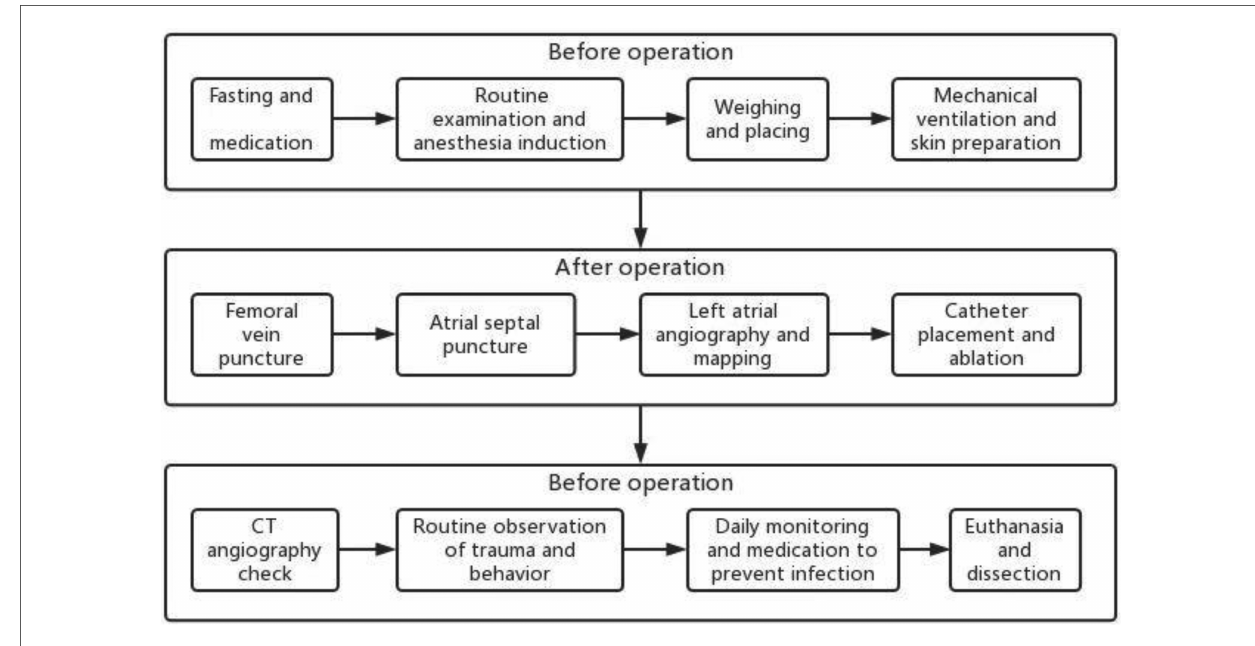
FIGURE 3 Procedure